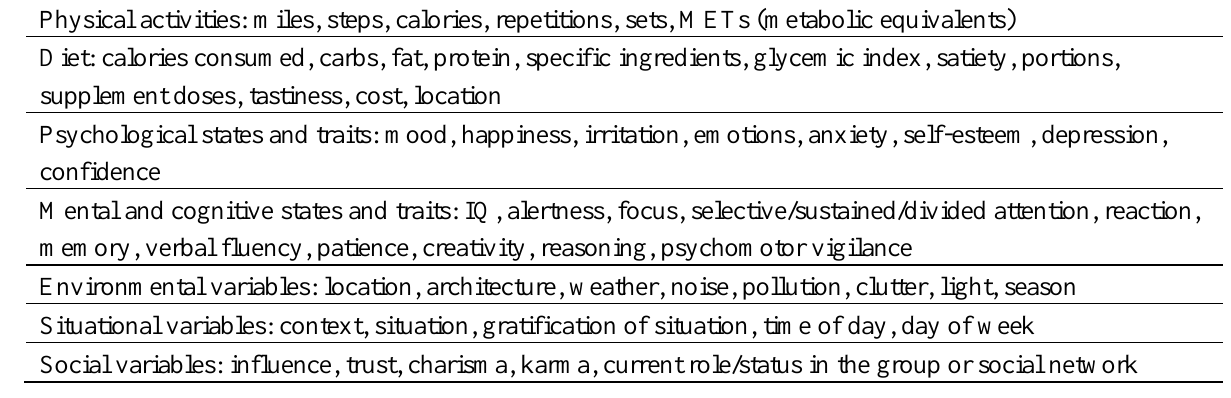
Table 1. Sample List of Quantified Self Tracking Categories and Variables. (Reproduced with permission from K. Augemberg